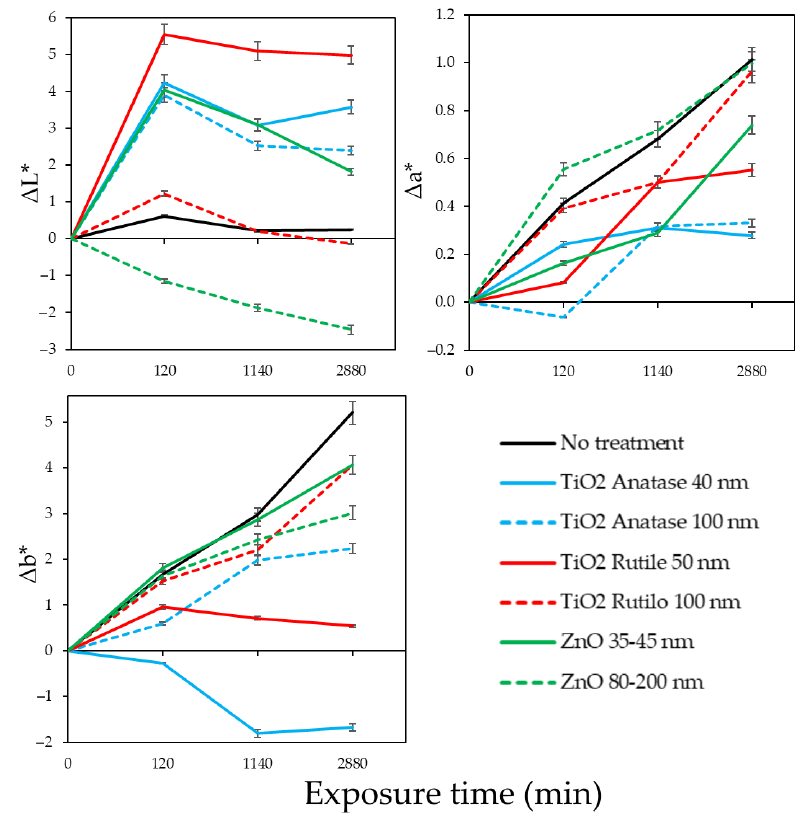
Figure 7. Changes in CIE L*a*b* color parameters Δ L*, Δ a*, and Δ b* of untreated control samples and samples treated with different NPs; before and after exposure to UV radiation at 340 nm. Bars represent 5% error.